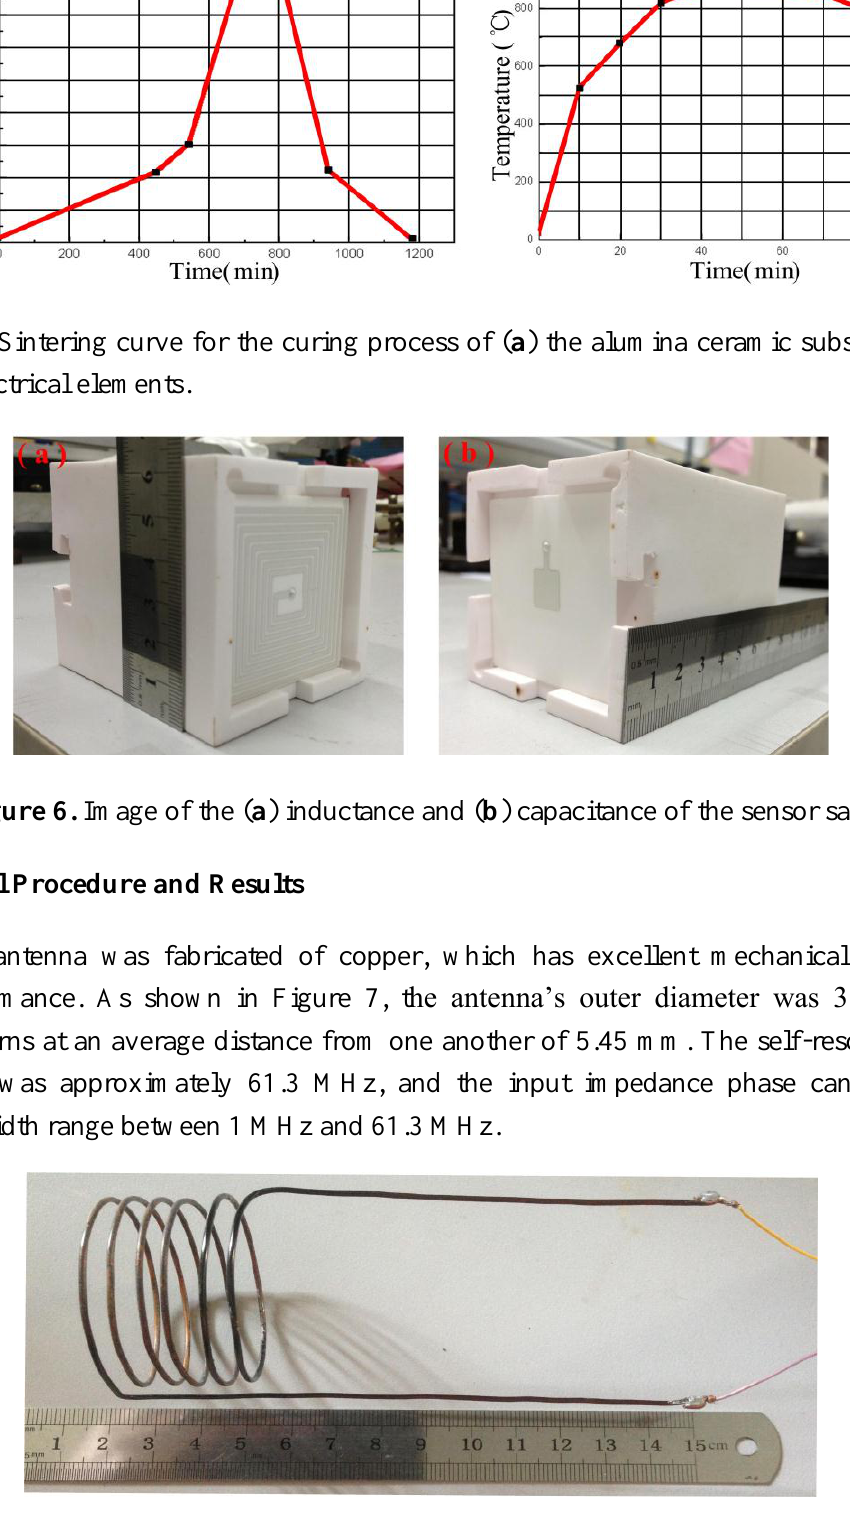
Figure 7. Reader